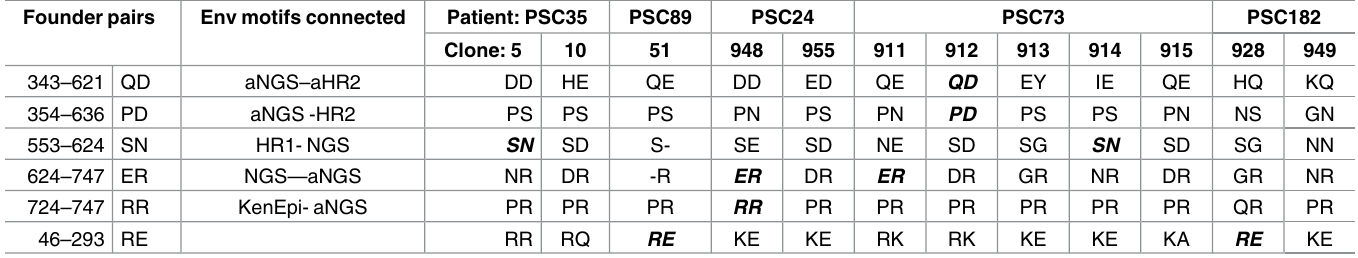
Table 4. Comparison of optimal Founder pairs with the AA combinations appearing for 5 subtype B pre-seroconverterswith each of the clones sequenced. Founder pairs Env motifs